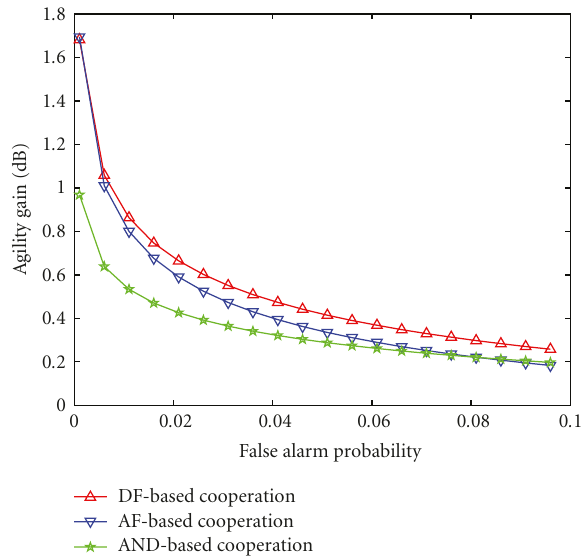
= 1, Figure 5: Agility gain versus false alarm probability with γ s = 10dB, p 1 ( σ p 2 /σ p 1 ) and μ = σ 2 p 1 = 1, η = 5dB and μ = 10dB, where η = 20log 10 ( σ 21 /σ p 1 μ = 20log 10